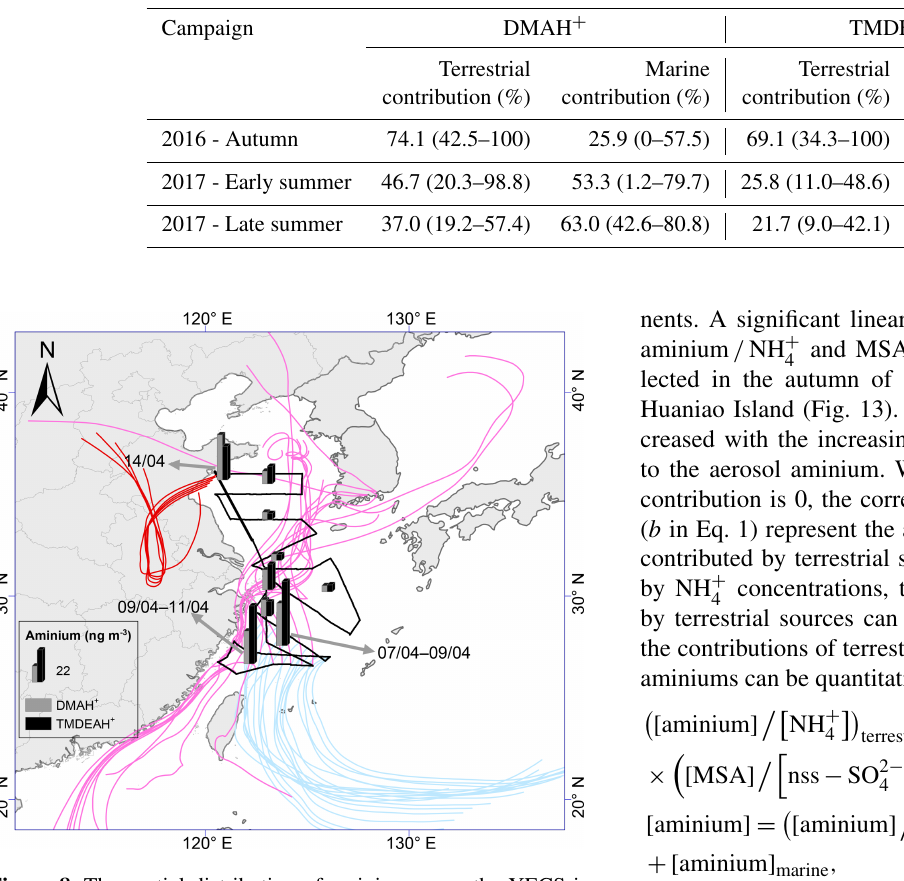
Table 3. Calculated terrestrial and marine source contributions to aerosol aminiums over Huaniao Island (mean; minimum–maximum).